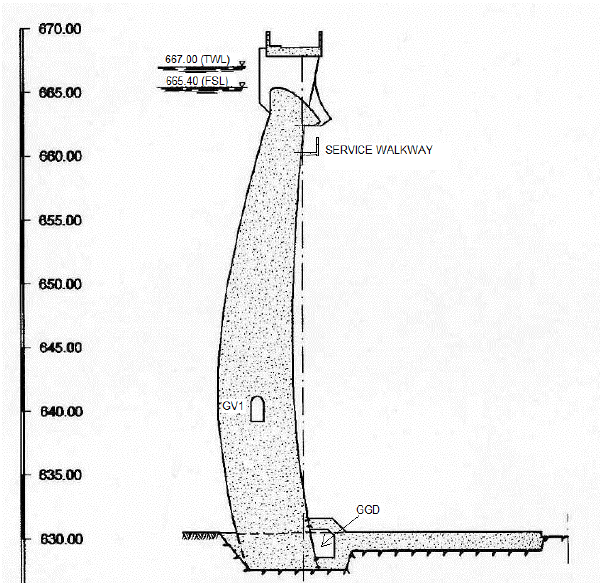
Figure 4. Central cross section.